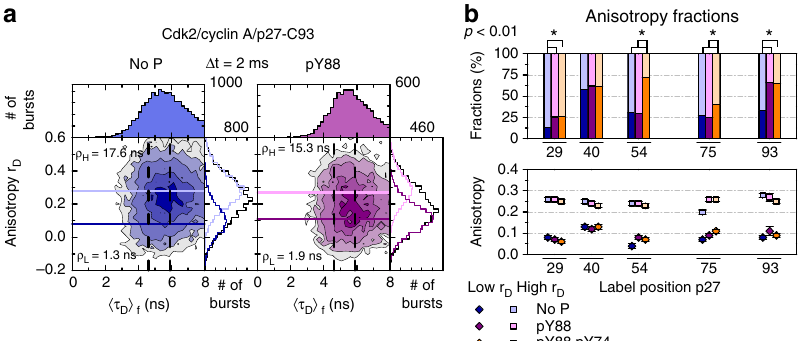
Fig. 4 Local dynamic fl uctuations selected residues within p27 bound to Cdk2/cyclin A detected by fl uorescence anisotropy. a Time-window analysis ( Δ t = 2 ms) for BODIPY-labeled p27-C93 (blue) and pY88-p27-C93 (purple) bound to Cdk2/cyclin A are shown as two-dimensional frequency histograms of scatter-corrected fl uorescence anisotropy ( r D ) vs . the fl uorescence-weighted average BODIPY fl uorescence lifetime ( 〈 τ D 〉 f ). Contours correspond to various levels of occurrences. One-dimensional histograms are the projected distributions over a single variable (right Anisotropy; top 〈 τ D 〉 f ). Number of single-molecule events or # of bursts are shown at the right top corner of each condition. Probability distribution analysis (PDA) is used to fi t the r D distributions with two shot-noise limited states (high r D and low r D , light and dark colors, respectively). Mean values of high r D and low r D are shown as solid lines over the two-dimensional histogram. Vertical dashed lines are identi fi ed BODIPY lifetimes. These values are used to calculate the proper rotational correlation times ( ρ H and ρ L for high r D and low r D , respectively) for each state using Perrin ’ s equation (Supplementary Equation 9; Supplementary Table 1-3; Supplementary Figure 4). b Global fi ts using PDA for three time-windows ( Δ t = 1 ms, 2 ms and 3 ms) are presented for each single Cys variant (C29, C40, C54, C75, and C93). The corresponding fractions and anisotropy values for the low and high r D are presented in light and dark colors, respectively. The average percentage error over all fractions is 7.0%. Individual errors are found in Supplementary Table 2. p < 0.01 signi fi cance between fractions are shown with an static FRET line (Fig. 5a, green curve; Supplementary Table 5),